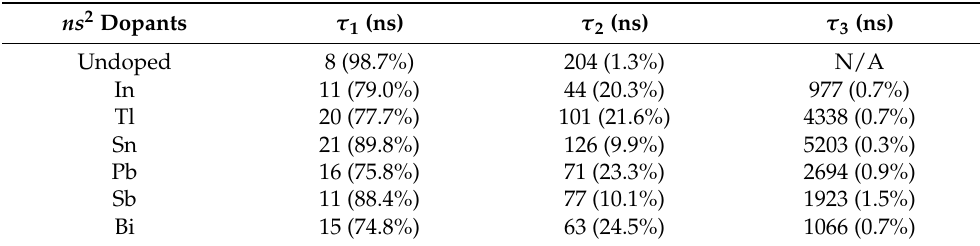
Table 3. Scintillation decay time constants of ns 2 ion-doped and non-doped Ga 2 O 3 . Reproduced from Reference [107] with